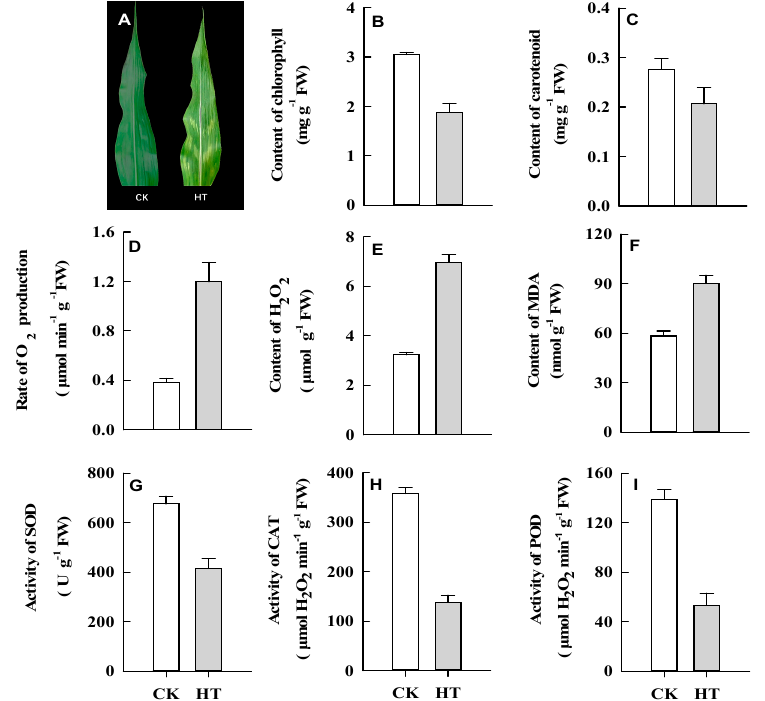
Figure 1. Effects of high temperature on phenotype ( A ), photosynthetic pigments ( B , C ), reactive oxidative species ( D , E ), lipid peroxidation ( F ) and antioxidase ( G – I ) of maize leaves.